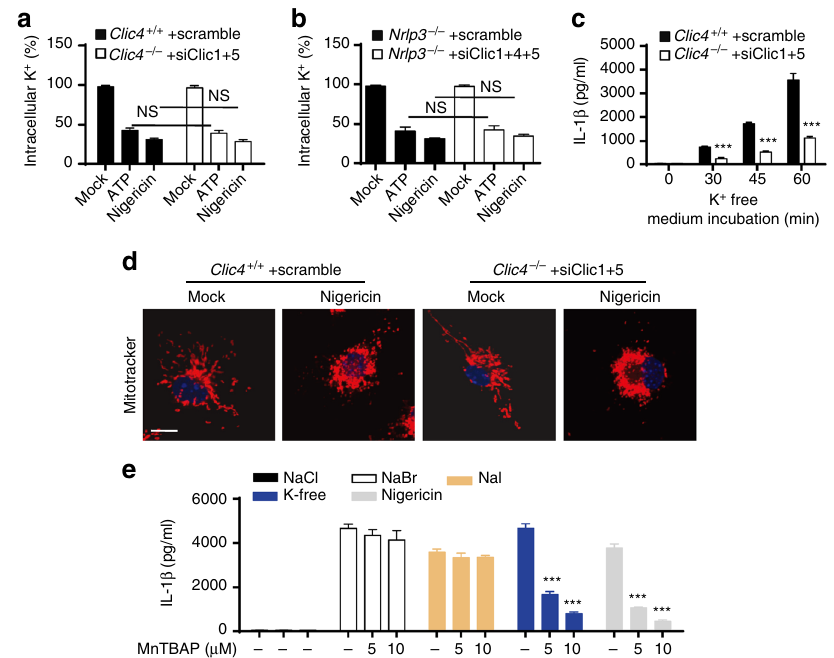
Fig. 6 Clics act downstream of potassium ef fl ux or mitochondrial damage to promote NLRP3 activation. a , b Quali fi cation of the decrease of intracellular potassium in LPS-primed Clic4 – / – BMDMs transfected with siRNA against Clic1 and Clic5 a or Nlrp3 – / – BMDMs tranfected with siRNA against Clic1 , Clic4 and Clic5 b and left stimulated with ATP or nigericin. c ELISA of IL-1 β in supernatants of LPS-primed Clic4 – / – BMDMs transfected siRNA against Clic1 and Clic5 and left transferred to potassium-free saline (135 mM NaCl, 1 mM MgCl 2 , 1 mM CaCl 2 , 20 mM HEPES (pH 7.4), 1 mg/ml BSA, 10 mM glucose) for 3 h. d Confocal microscopy analysis of LPS-primed Clic4 – / – BMDMs transfected with siRNA against Clic1 and Clic5 and then left stimulated with nigericin, followed by staining with Mitotracker red and DAPI. e ELISA of IL-1 β in supernatants of LPS-primed BMDMs transfected stimulated with nigericin or transferred to NaBr, NaI saline or potassium-free saline with or without the presence of indicated doses of MnTBAP. Data are from three independent experiments with biological duplicates in each ( a – c , e ; mean ± SEM of n = 6) or are representative of three independent experiments d . Two-way ANOVA e , Student ’ s t -test a – c , *** P < 0.001, NS not signi fi